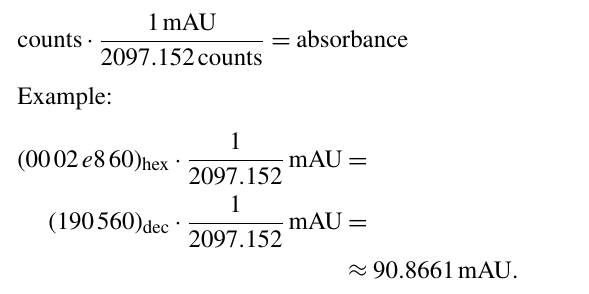
positive) describing one peak in the default